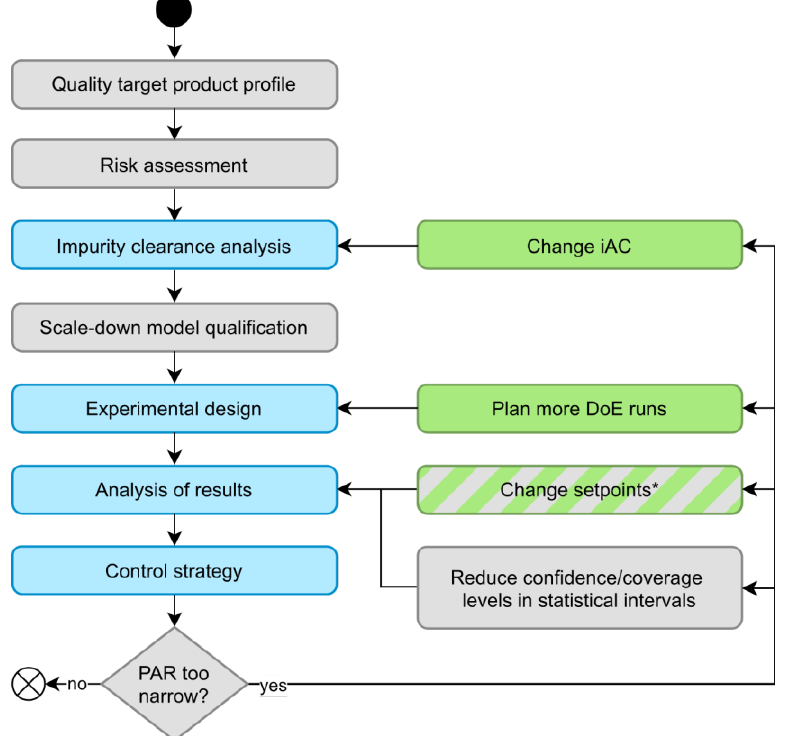
Figure 10. The left column represents common steps involved in process characterization, while the right column contains possible courses of action when no appropriate control strategy can be found. Green boxes are actions recommended by hDoE, and steps affected by hDoe are colored blue. * Changing PP setpoints could also be a viable, recommended action by future iterations of hDoE (see Section